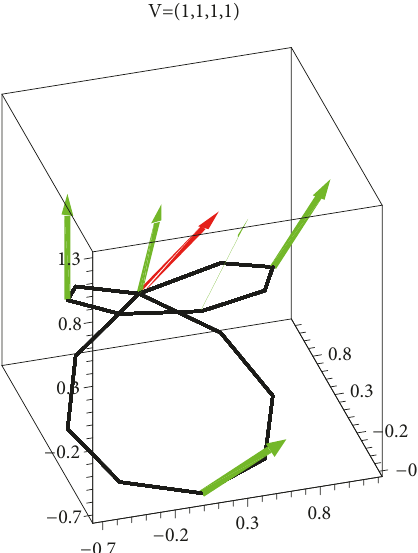
Figure 4: Red vector is 𝛾 󸀠 (0) = {2,0, 1,0} , and green vectors are magnetic fields 𝑉 = (1/2){1,1, 1,1} .